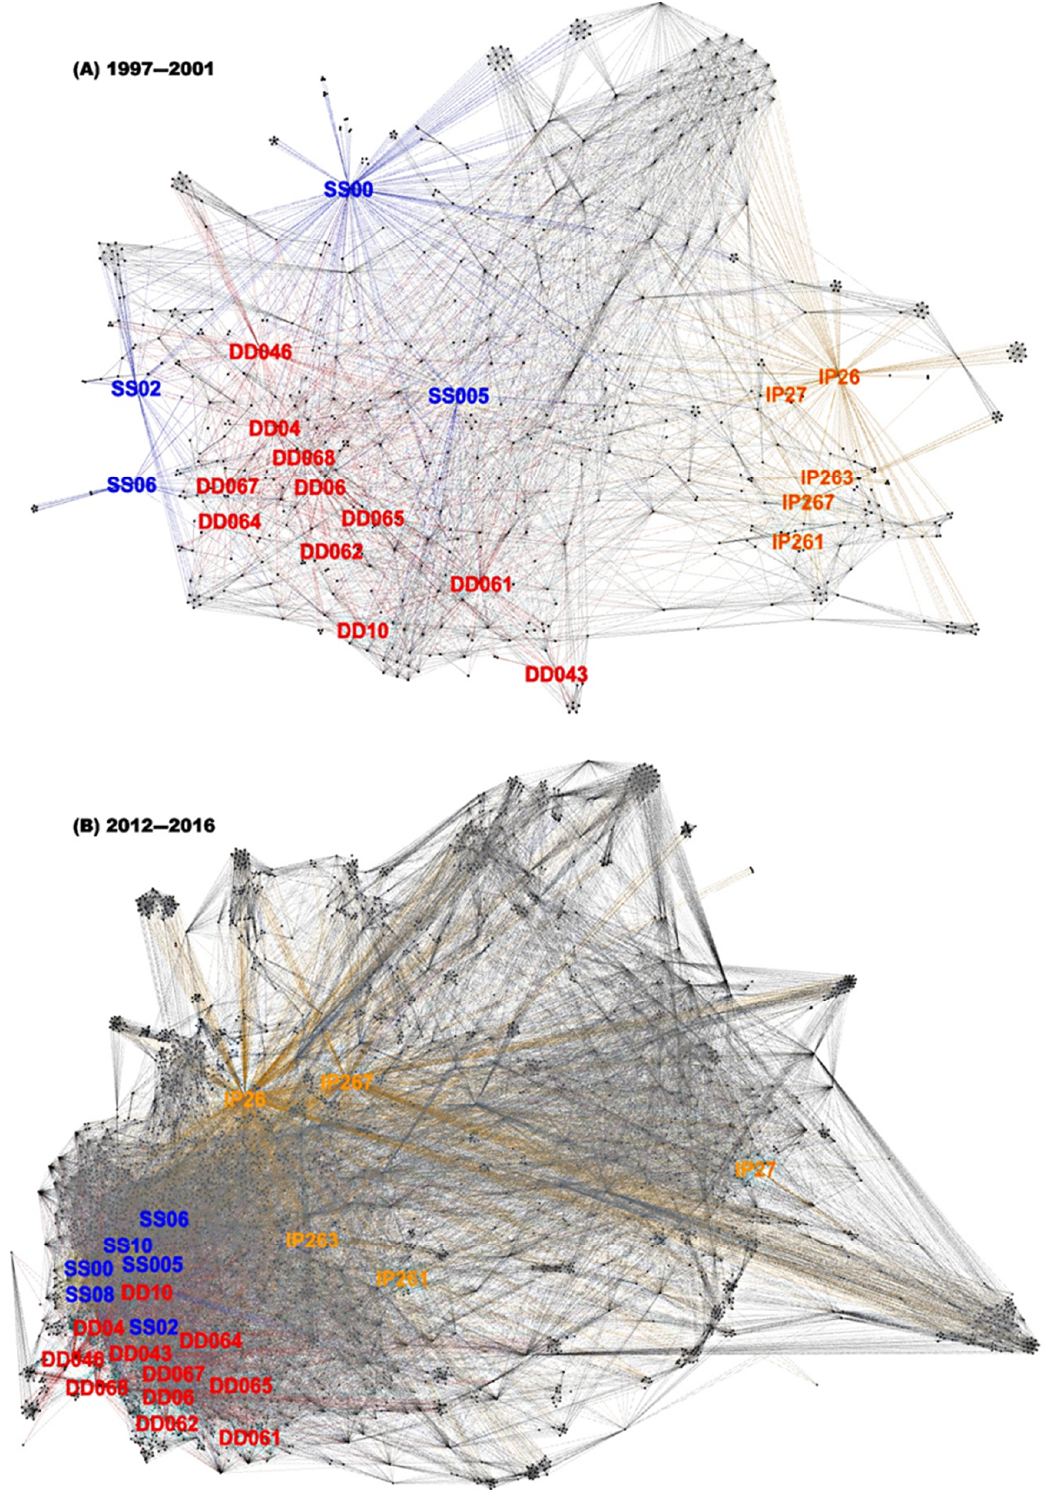
Figure 3. The network of technological relatedness of shale petroleum technologies for 1997 to 2001 ( A ) and 2012 to 2016 ( B ).